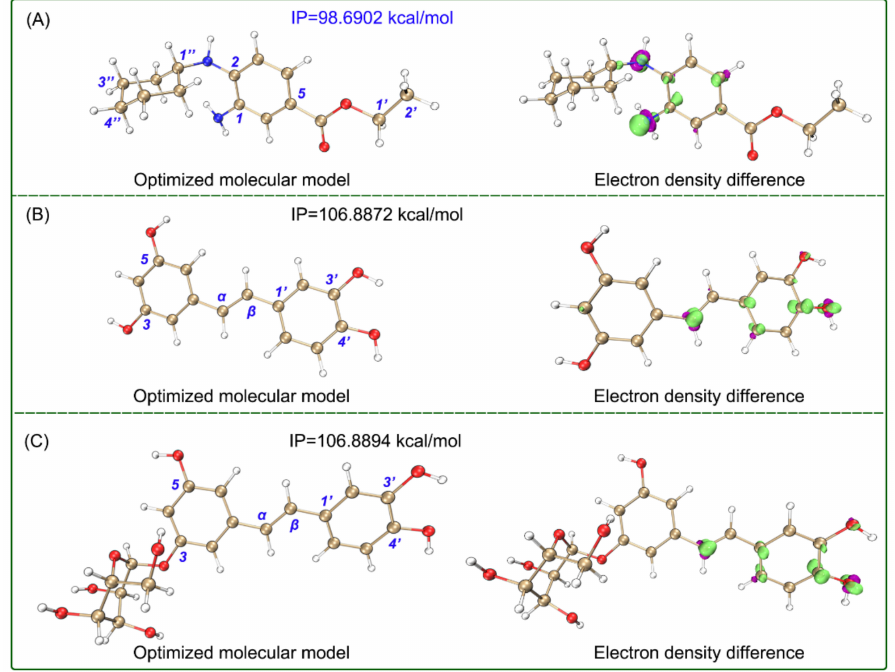
Figure 5. Optimized molecular model with the IP value and isosurface map of the electron density difference between a neutral molecule and cationic radical ( A , Fer-1; B , piceatannol; C, astringin) in the methanol SMD solvation model. The calculations were based on M06-2X-D3/6-311+G** and M06-2X-D3/def2-TZVPD calculation levels. In the isosurface map, lime and purple colors correspond to the regions where the electron density is increased and decreased, respectively (isovalue = 0.008). The Cartesian coordinates and energies of the optimized neutral molecules are listed in Supplemen- tary Material